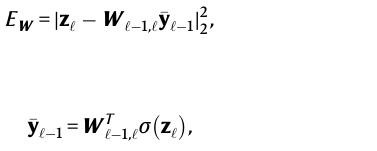
Theleftmostcolumnincludes theparametersupdatedusing F 0 with feedbackalignment,and thenextcolumnindicateslayerstrainedwith F eHebb (Eq.(8)).Angles α ℓ representthealignment between the modulatory signal e ℓ andthe backpropagated counterpart e BP ‘ at each layer (in degrees).Since e 0 isasyntheticerror,theeffectofthe F eHebb on W 0,1 alonehasbeenexcluded. Themodel istrainedfor 500episodes,and thecomputed anglesareaveraged after a burn-in period of100